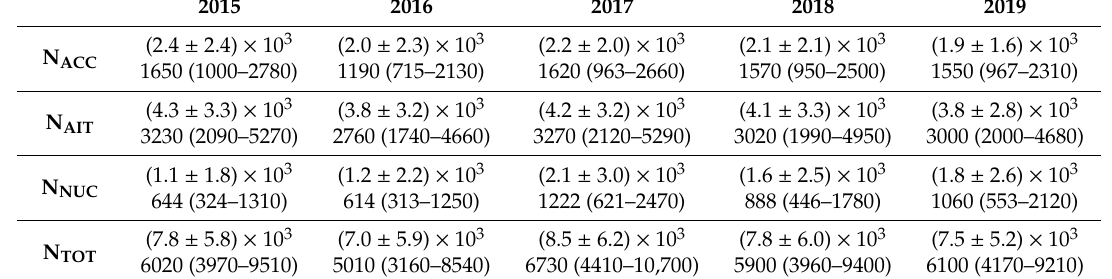
Table 1. Yearly averages ± 1 standard deviation and medians (25th–75th) percentiles of the total, accumulation, Aitken, and nucleation number concentrations (cm − 3 ).